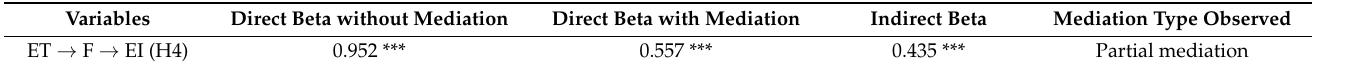
Table 7. Mediation